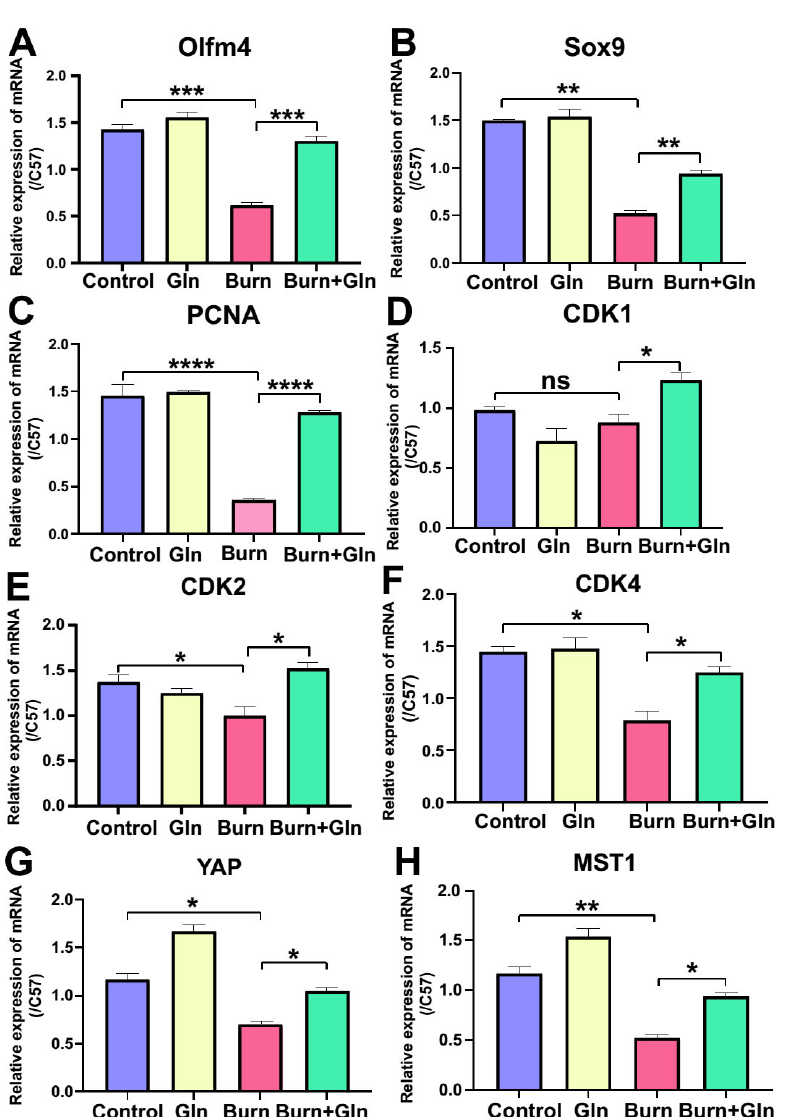
Figure 7. Gln accelerates the small intestine stem cell cycle process and promotes self-renewal. ( A – C ) The expression of the mRNA with stem cell markers in the four different groups according to the quantitative by Real-Time Quantitativeq Polymerase Chain Reaction (RT-qPCR). ( A ) Olfactomedin 4 (Olfm4) mRNA expression. ( B ) Sulfur Oxides 9 (SOX9) mRNA expression. ( C ) Proliferation Cell Nuclear Antigen (PCNA) mRNA expression. ( D – F ) The expression of the mRNA related to cell cycle of mouse small intestine crypts was measured by RT-PCR from the 4 different groups on day 3 after burn: ( D ) Cyclin-Dependent Kinase12 (CDK1) mRNA expression. ( E ) Cyclin-Dependent Kinase 2 (CDK2) mRNA expression. ( F ) Cyclin-Dependent Kinase 4 (CDK4) mRNA expression. ( G ) Yes-associated Protein (YAP) mRNA expression. ( H ) Mammalian sterile 20-like kinase 1 (MST1) mRNA expression. Data were expressed as mean ± SEM from 6 independent experiments ( n = 6), ns no significance, * p < 0.1, ** p < 0.01 *** p < 0.001, **** p < 0.0001 using 1-way ANOVA and post hoc Tukey’s